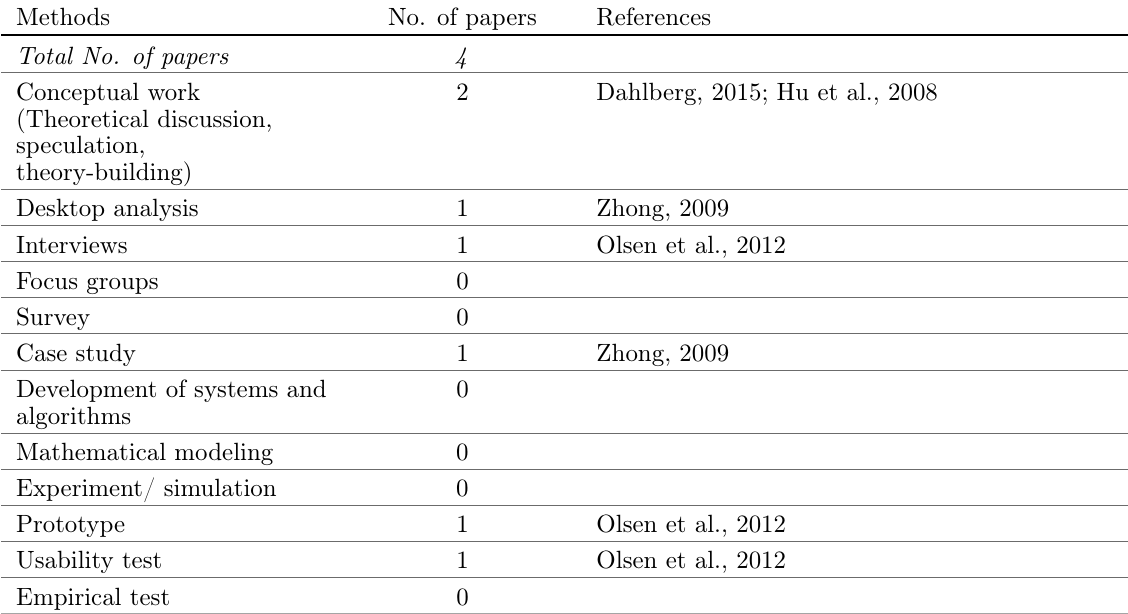
Table B.6 . Research methods used in studies on mobile payment